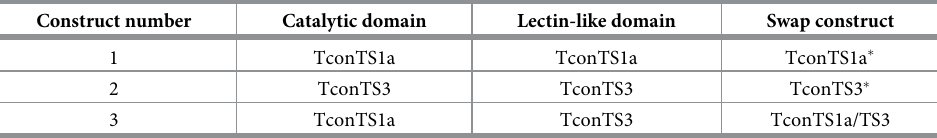
Table 4. TconTS constructs generated in this